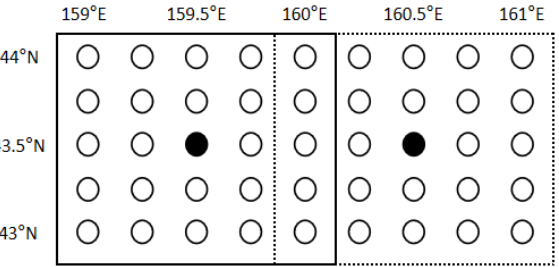
Figure 2. Example of data expansion in fisheries’